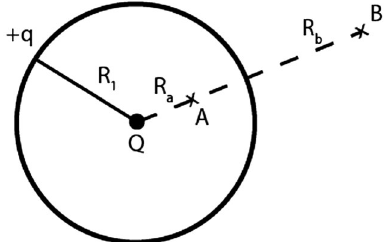
FIG. 13. Figure used for post-test problem PII-6. An insulating shell with positive charge þ q surrounds a positive point charge Q . The problem asks what will happen to the potential difference between A and B , V AB , if the radius of the shell becomes